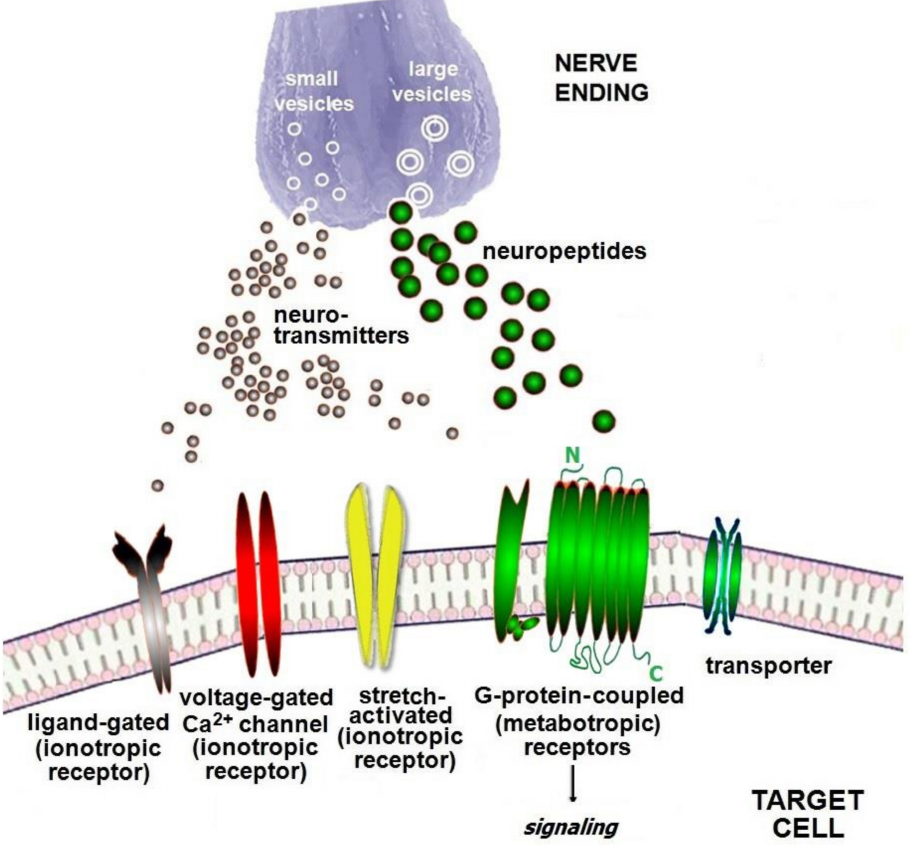
Figure 1. Receptors for neurotransmitters and neuropeptides. The nerve ending enables the release of two types of neuro molecules, neurotransmitters from the small vesicles and neuropeptides from large vesicles. Receptors for neurotransmitters expressed on the target immune cell membrane are divided into ionotropic and metabotropic. The ionotropic receptors of some subtypes possess ion channels, whereas metabotropic receptors, or transmembrane GPCRs, use various signaling pathways. Neuropeptides exploit metabotropic-like GPCPs. Transporters help neuro molecules move through the